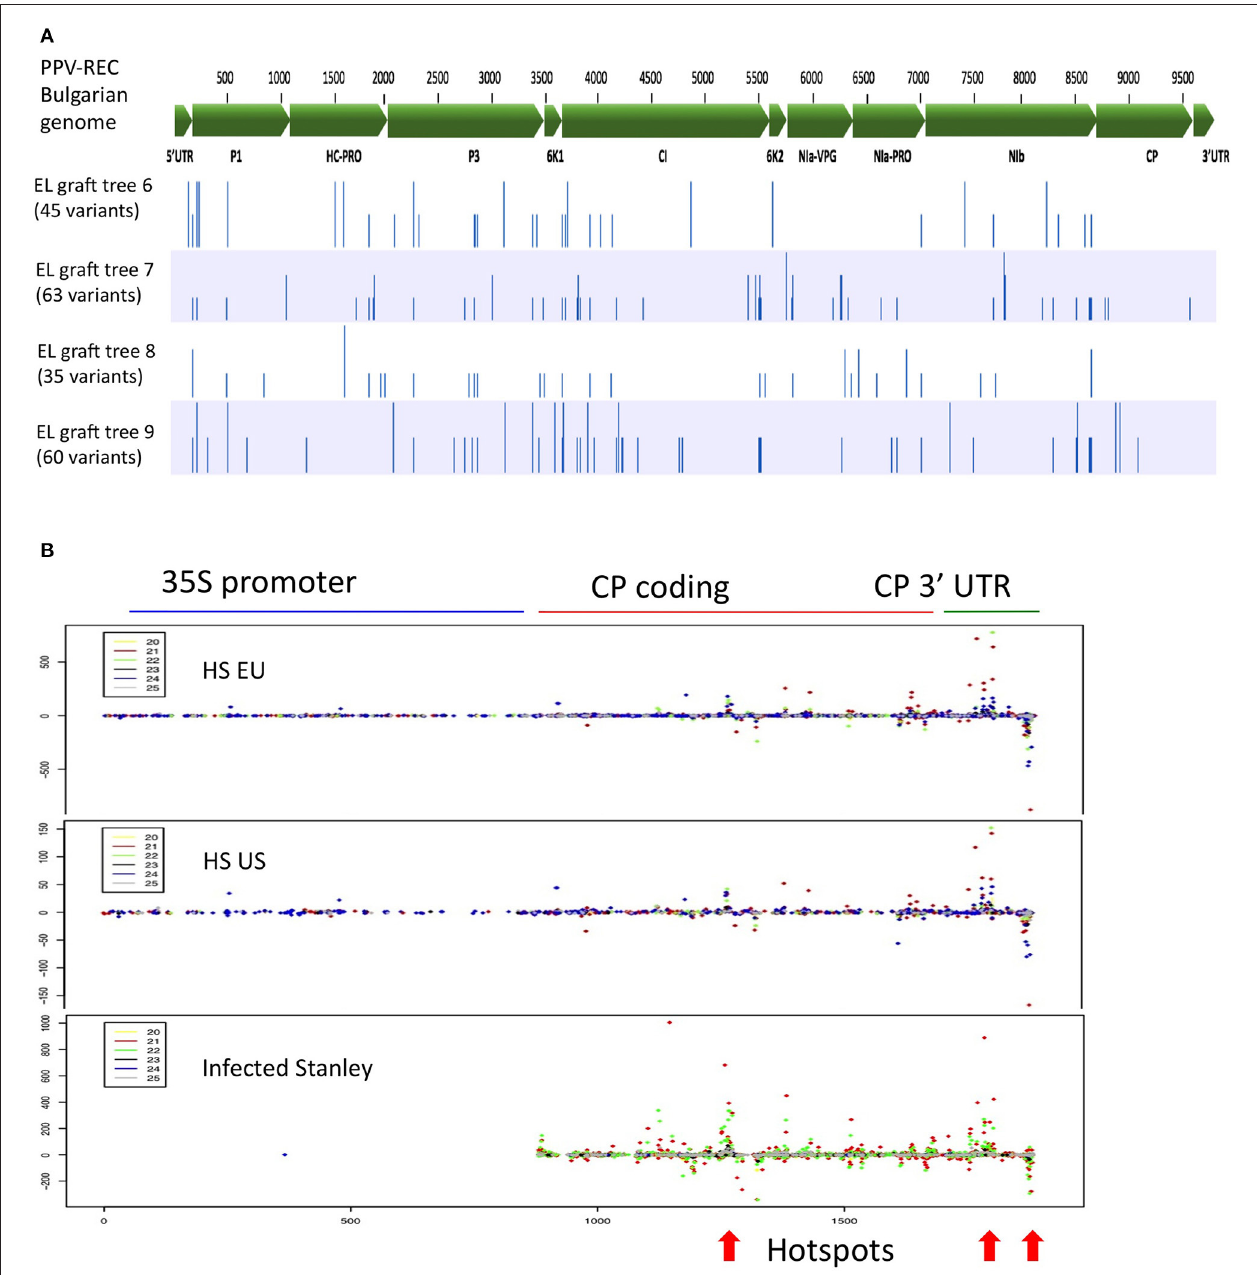
FIGURE 3 | Distribution of mutations in the PPV-REC genome after 10 years of exposure and the distribution of sRNAs related to the CP gene after 9 years of growth. (A) Sequence variation of the viral PPV-REC genome found in four different grafts of ‘Emma Lepperman’ on ‘HoneySweet’ for over 10 years. Variant analysis was performed by aligning viral sRNA reads (vsRNA) to the whole genome of PPV-REC strain of PPV including 5 ′ and 3 ′ UTRs. Genes and their positions on the genome are marked on the top with a green bar while variants are marked with blue bars for the individual tree. (B) Fruit sRNAs were mapped to the PPV-CP and promoter sequence of the transgene in ‘HoneySweet’ or the PPV CP in ‘Stanley.’ Each block represents the sRNAs from European-grown ‘HoneySweet’ (HS EU), United States-grown ‘HoneySweet’ (HS US), and ‘Stanley’ naturally infected by PPV. Each color represents a different length of sRNA (yellow-20 nt, red-21 nt, green-22 nt, black-23 nt, blue-24 nt, gray-25 nt). Dots above the bar represent the number of positive-strand sRNAs and those below represent the number of negative strand sRNAs. There are several regions of sequence that have larger numbers of related sRNAs, so-called hotspots. These can be seen in all three conditions, including the naturally infected ‘Stanley,’ and are indicated by an arrow at the bottom of the figure.